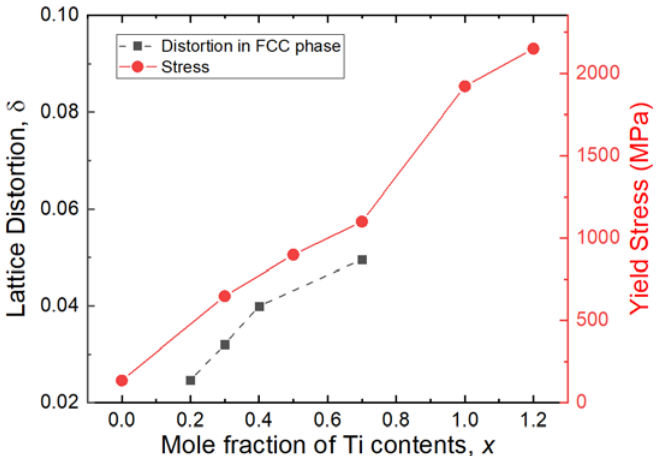
Figure 5. The correlation between the lattice distortion of FCC phase and yield stress as a function of Ti composition.